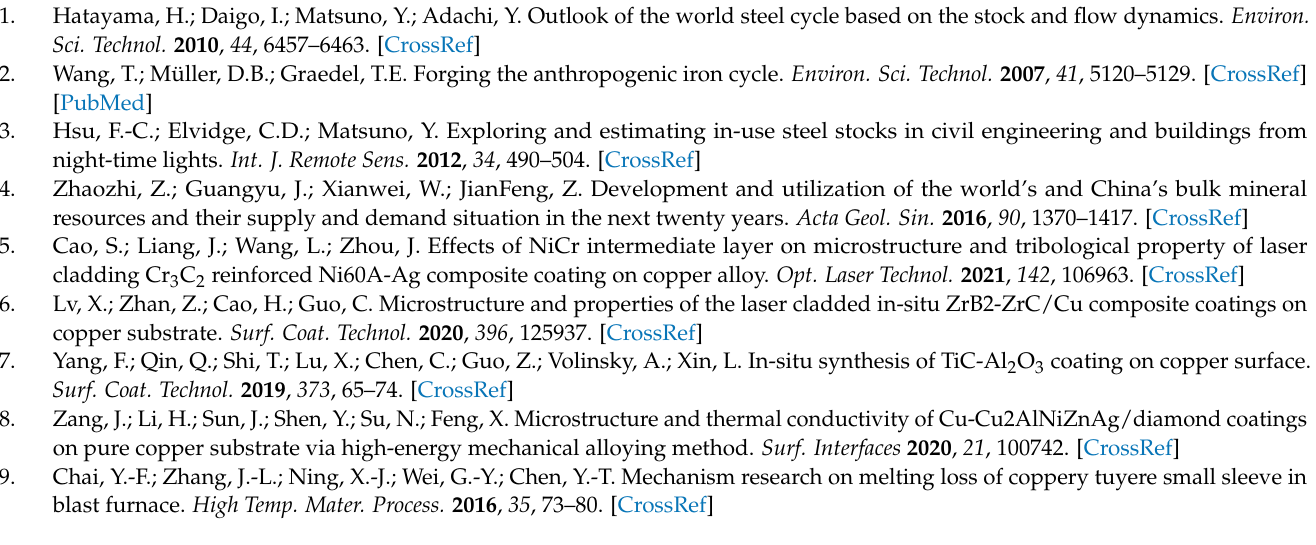
pipe, Figure S5: SEM micrograph of Ni60A coating, Figure S6: Cross-section SEM micrograph and the elemental mappings of cross-section of the Ni60A coating (S3), Table S1: Parameters of single-track plasma cladding